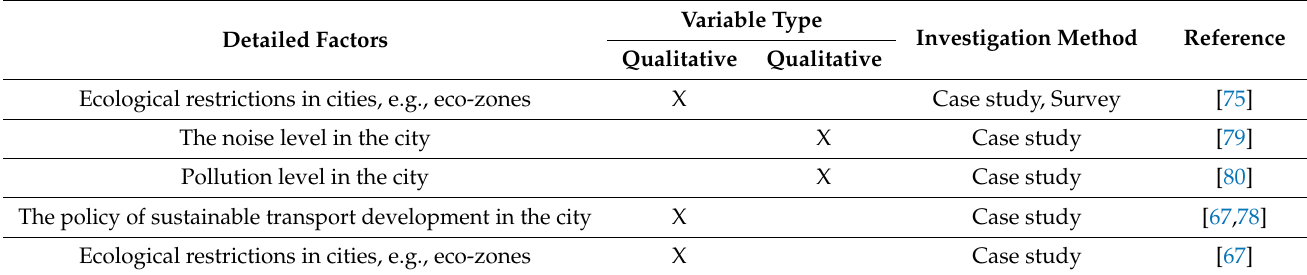
Table 11. Factors related to city features.